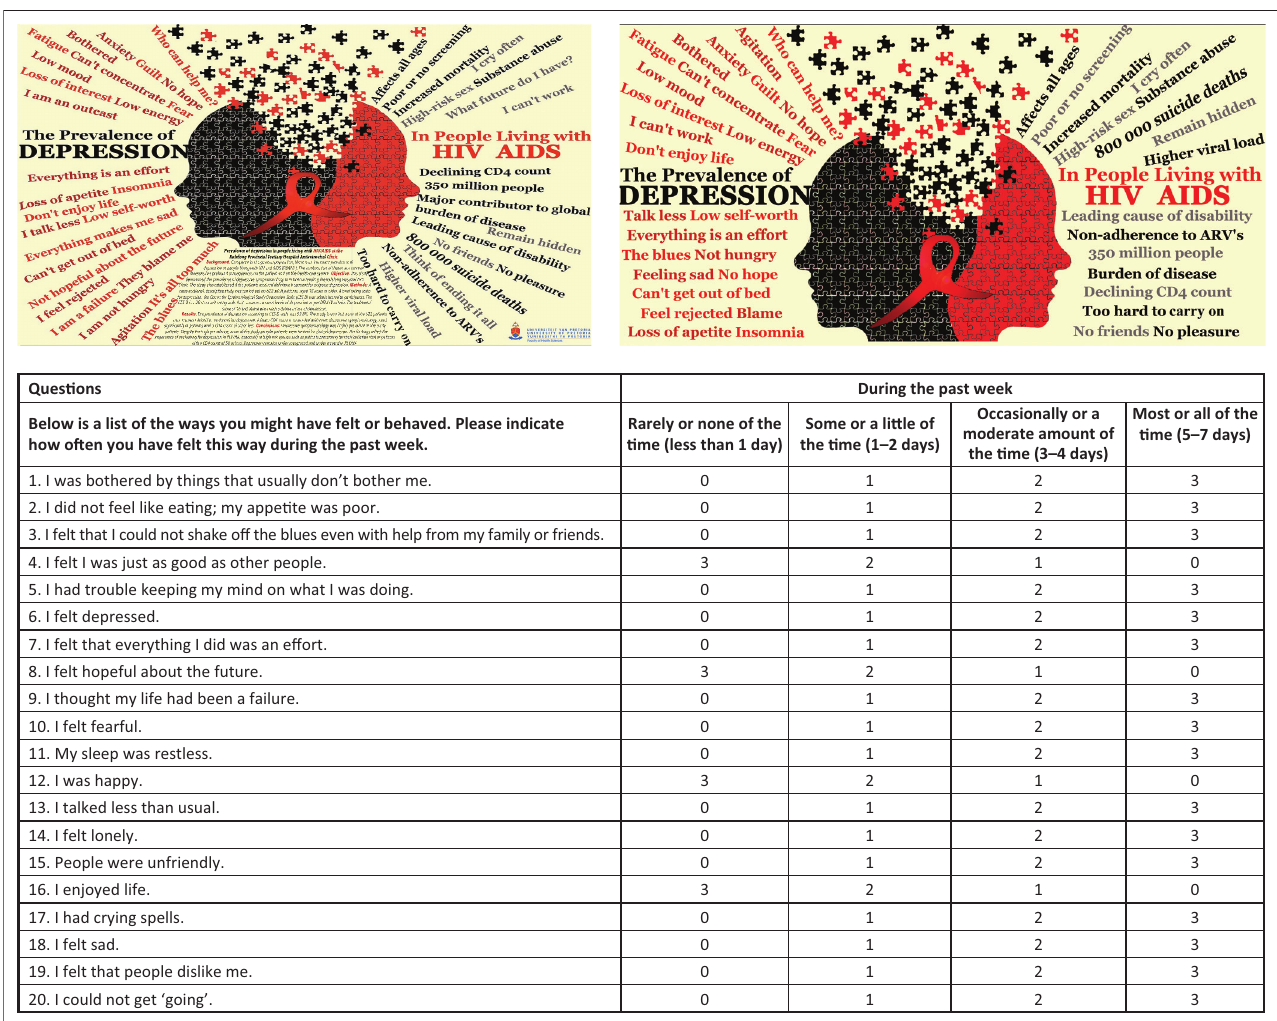
FIGURE 1: Centre for Epidemiological Studies Depression Scale (CES-D) scoring: 0 for answers in the first column, 1 for answers in the second column, 2 for answers in the third column, 3 for answers in the fourth column. The scoring of positive items is reversed, that is, items 4, 8, 12 and 16. Possible range of scores is 0–60, with the higher scores indicating the presence of more